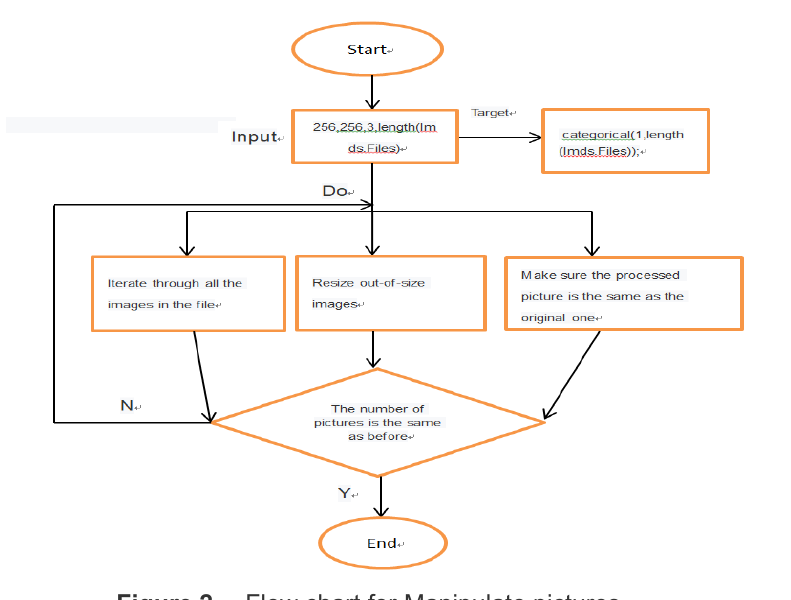
Figure 2. Flow chart for Manipulate pictures tongue-rolling pronunciation. SH. One image in the second Here, we present two sets of images. Two samples are group represents E, and the other image represents selected from 44 samples. Two images are drawn from each tongue-rolling ZH (see Figure 3 and Figure 4 ): set of samples. Among them, one image in the first group represents the letter T, and the other image represents the